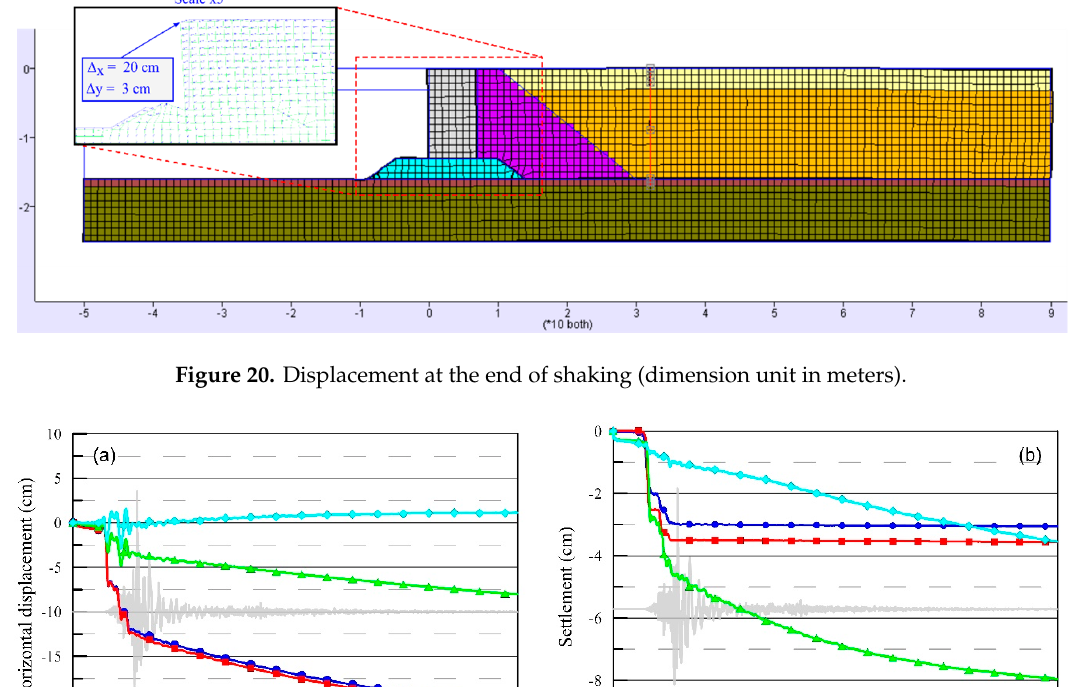
Figure 21. ( a ) Horizontal displacement (positive values are to the right side, and negative values are to the left side), and ( b ) settlement of the observed nodes in the analysis.